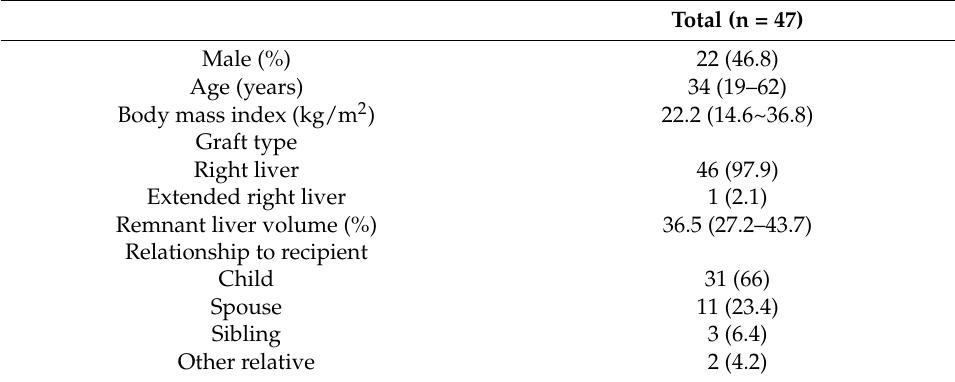
Table 2. Baseline characteristics of donors that underwent LDLT.